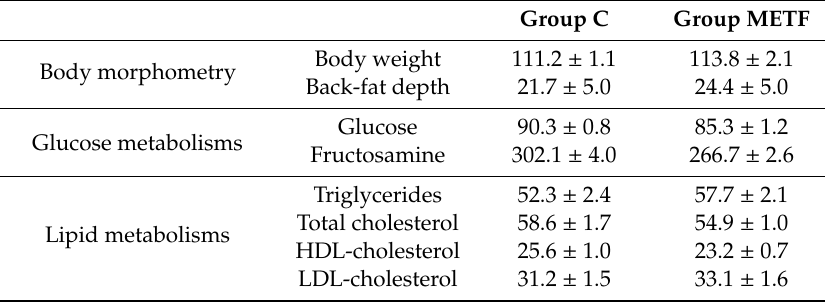
Table 1. Mean ( ± SEM) values for body-weight (kg), back-fat depth (mm), and plasma parameters (mg / dL) of glucose, fructosamine, and lipids [triglycerides and total-, high-density lipoproteins cholesterol (HDL-c), and low-density lipoproteins cholesterol (LDL-c)] in control (group C) and metformin-treated sows (group METF) at day 100 of